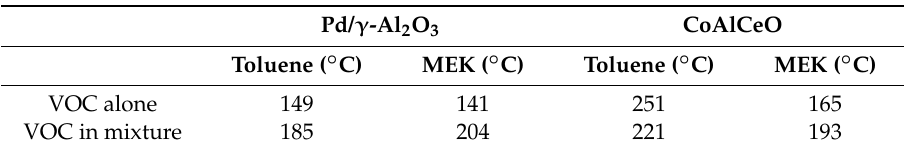
Table 5. Comparison of T 50 for the total catalytic oxidation of binary mixture for Pd/ γ -Al 2 O 3 and CoAlCeO